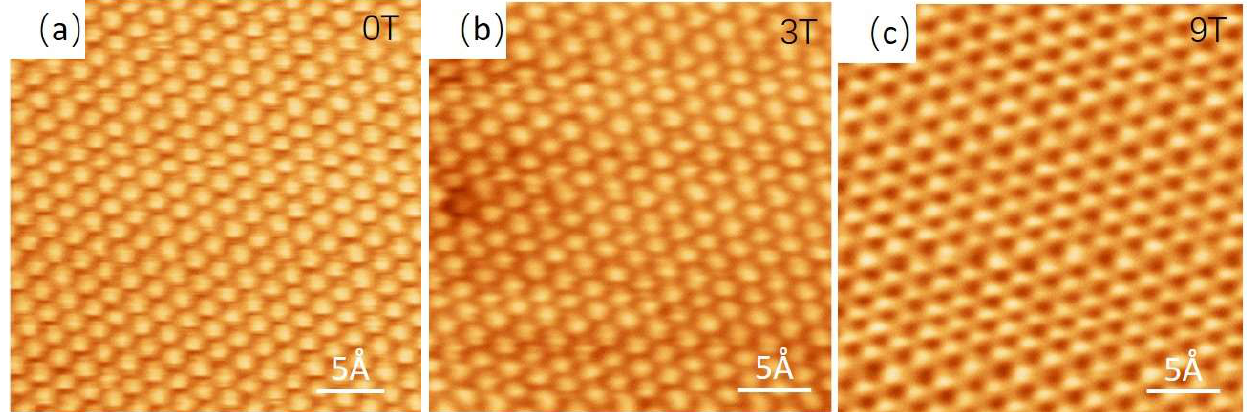
Figure 6. Atomic resolution images of graphite obtained at magnetic field of ( a ) 0 T, ( b ) 3 T, and ( c ) 9 T. The average tunneling current is 12.5 nA, and the scan speed is 10 lines/s.